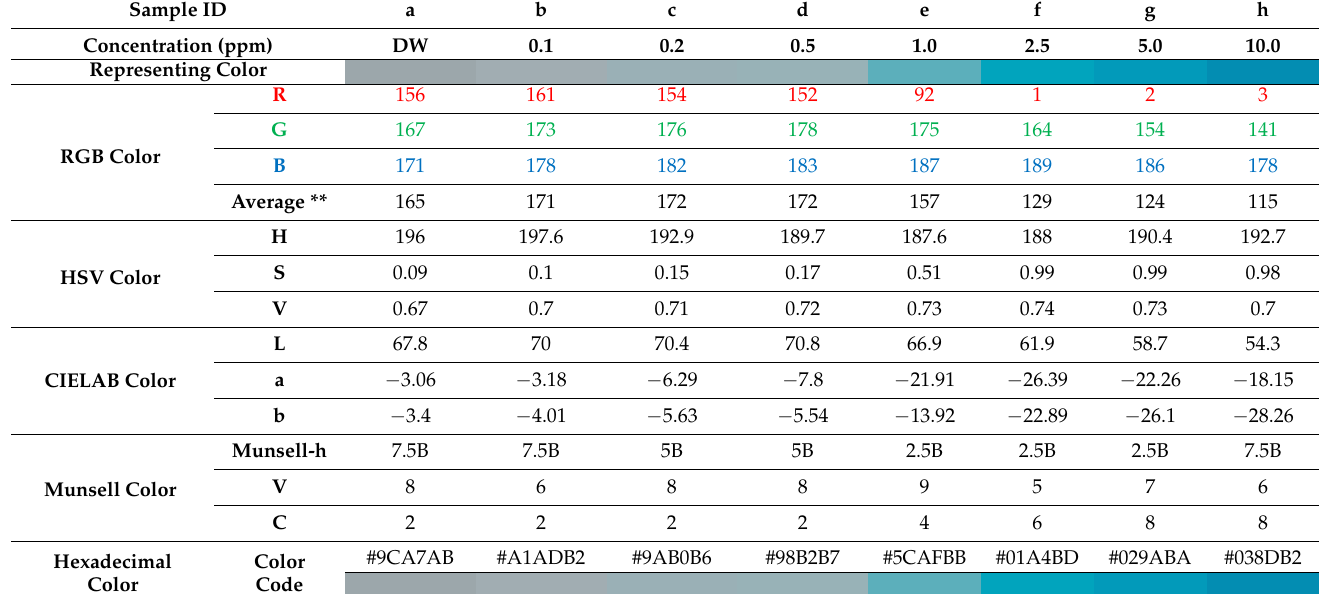
Table 2. Summary of color analysis results of MB solutions from 0.1 to 10 ppm in various